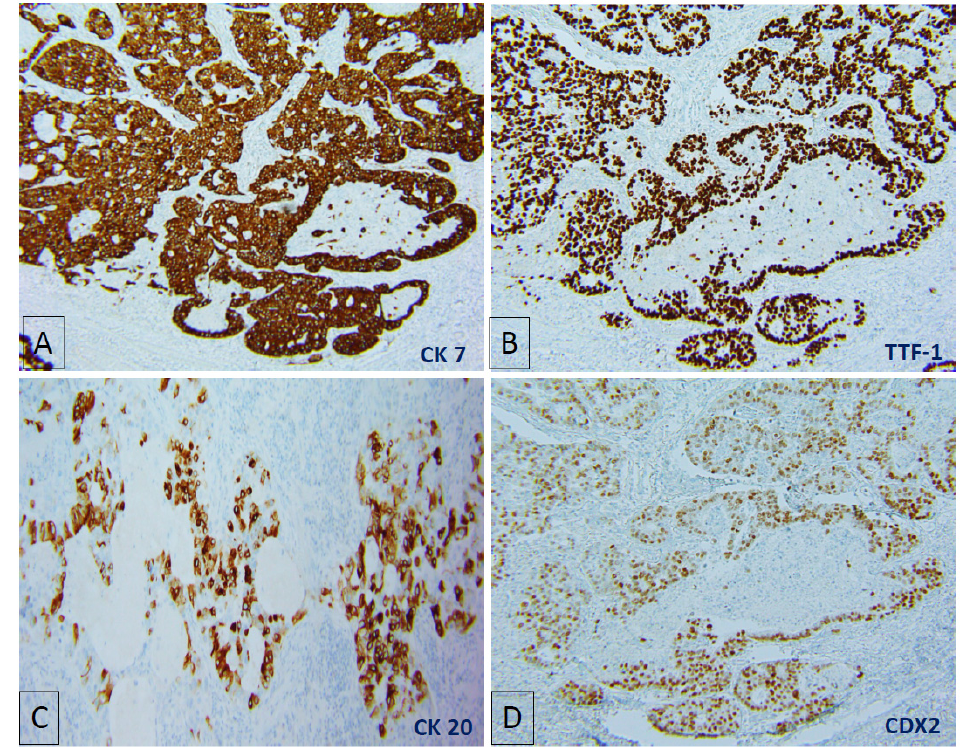
Figure 3. Immuno-stains showing strong and diffusely positive CK7 ( A ) and TTF-1 ( B ), with some CK20 ( C ) and CDX2 ( D ) expression.